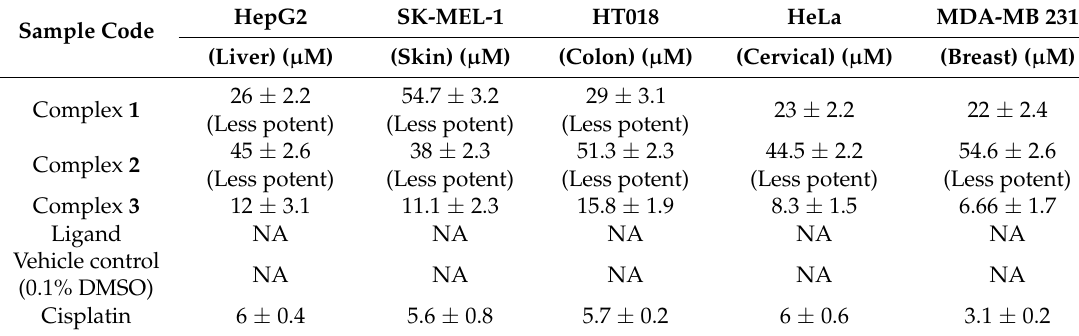
Table 3. IC 50 values of complexes 1 – 3 , ligand, and cisplatin against five human cancer cell lines. Sample Code